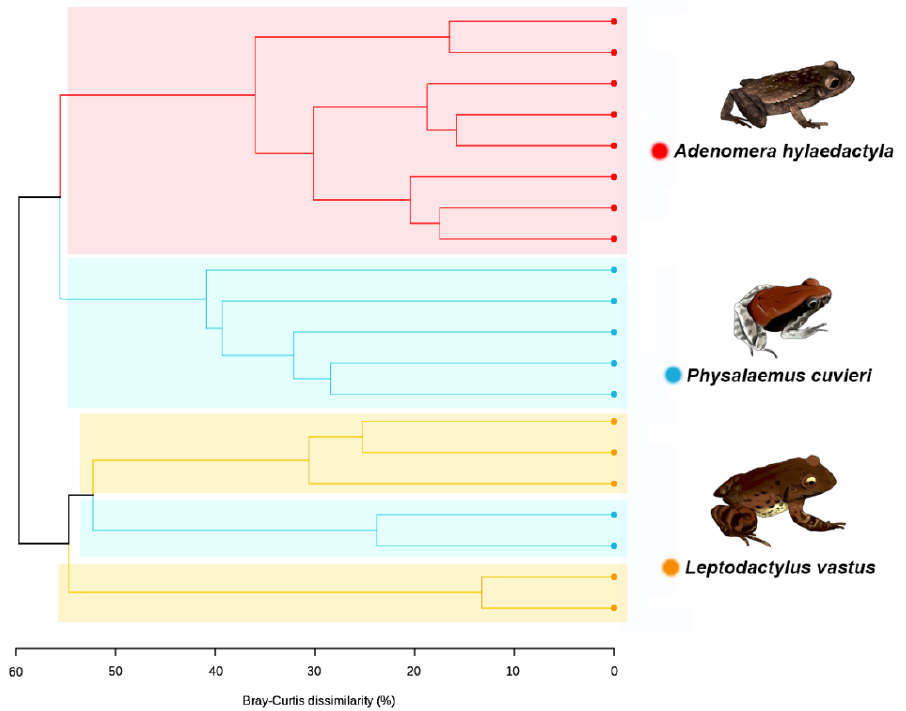
Figure 6. Dendrogram generated via UPGMA clustering analysis using the amplicon sequence var- iants (ASVs) at bacterial genus level, showing the relationship among the frog species. variants (ASVs) at bacterial genus level, showing the relationship among the frog